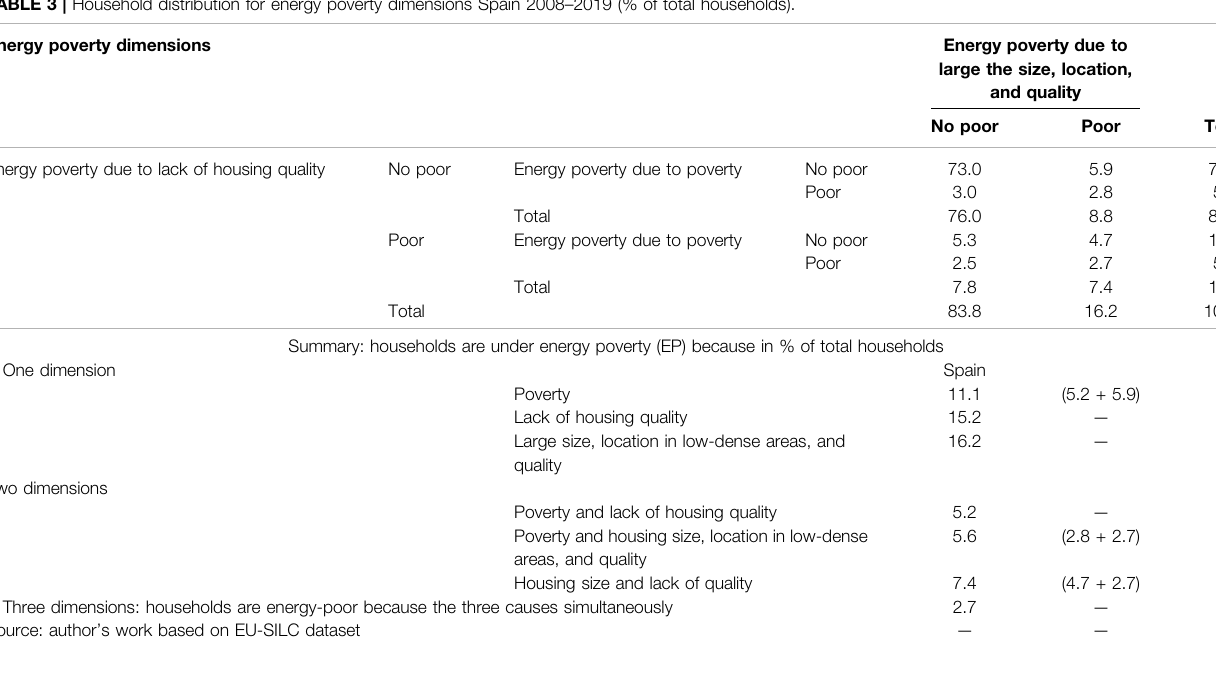
TABLE 3 | Household distribution for energy poverty dimensions Spain 2008 – 2019 (% of total